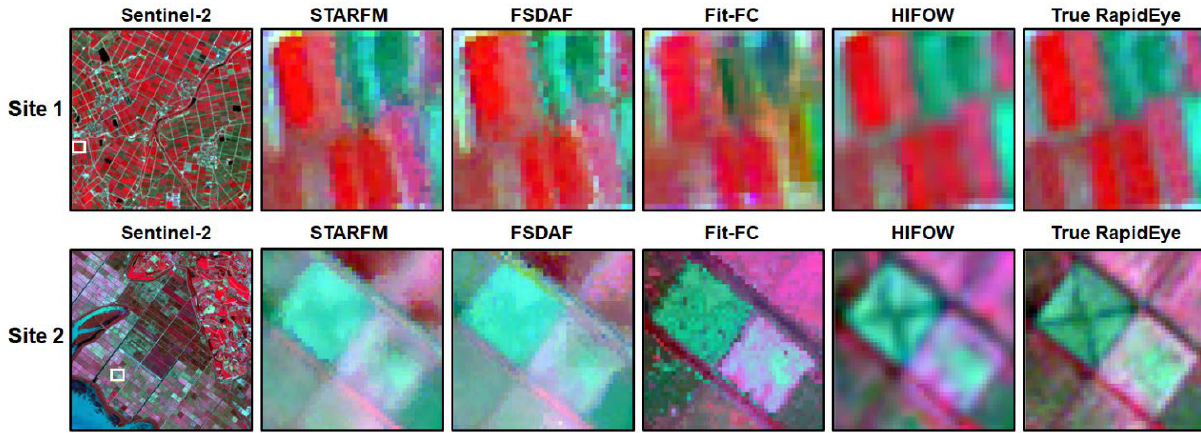
Figure 7. Prediction results of different STIF models with Sentinel-2 (10 October. 2019) and RapidEye images (9 October. 2019) at the prediction date at Site 2. All color composite images are displayed with NIR-red-green as RGB.